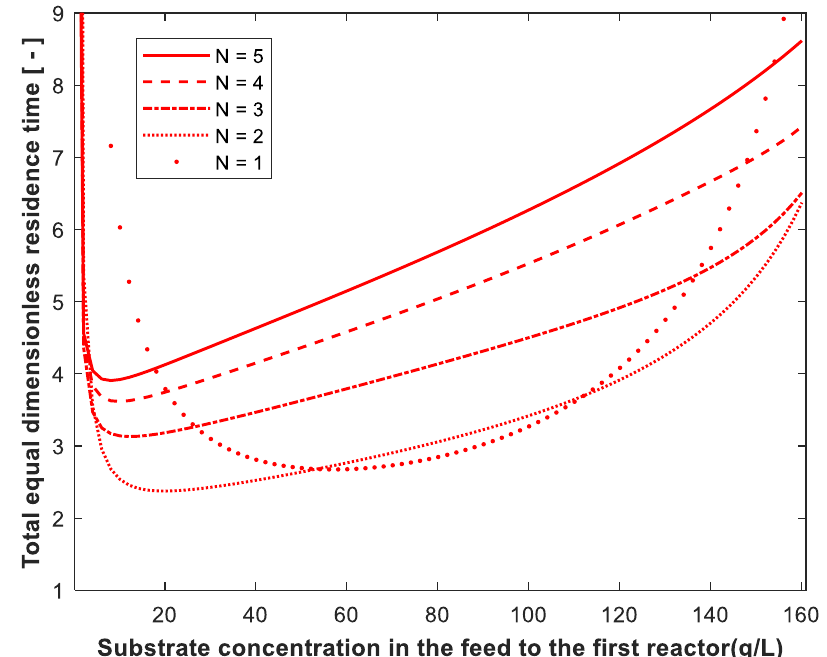
Figure 9. Effect of substrate concentration in the feed to the first reactor on the total dimensionless residence time of equal-volume reactors in series. Substrate conversion: 99%. X o = 0.01 g/L. P o = 0. N = 1 is shown for